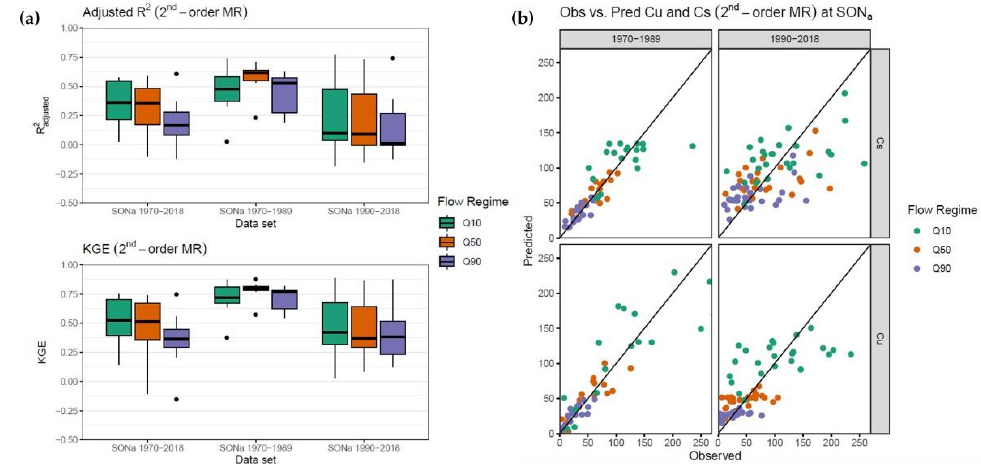
Figure 6. ( a ) Evaluation metrics boxplots and ( b ) predicted–observed scatterplots of MR models (2nd-order, Niño 3.4–DMI predictors, SON a set) with three different window periods: 1970–2018, 1970–1989, and 1990–2018. The boxplots show the metrics for all rivers, while the scatterplots only show the plots for Cs and Cu Rivers.